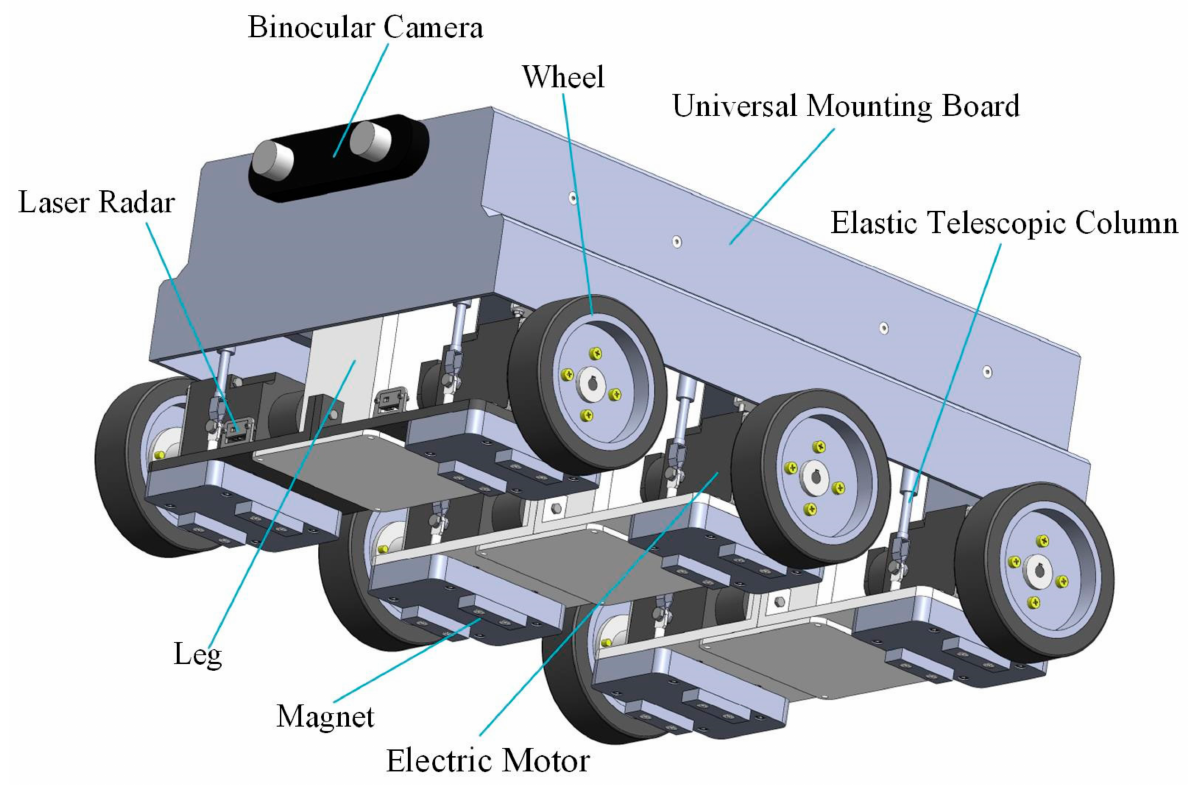
Figure 2. Mechanical structure of magnetic climbing